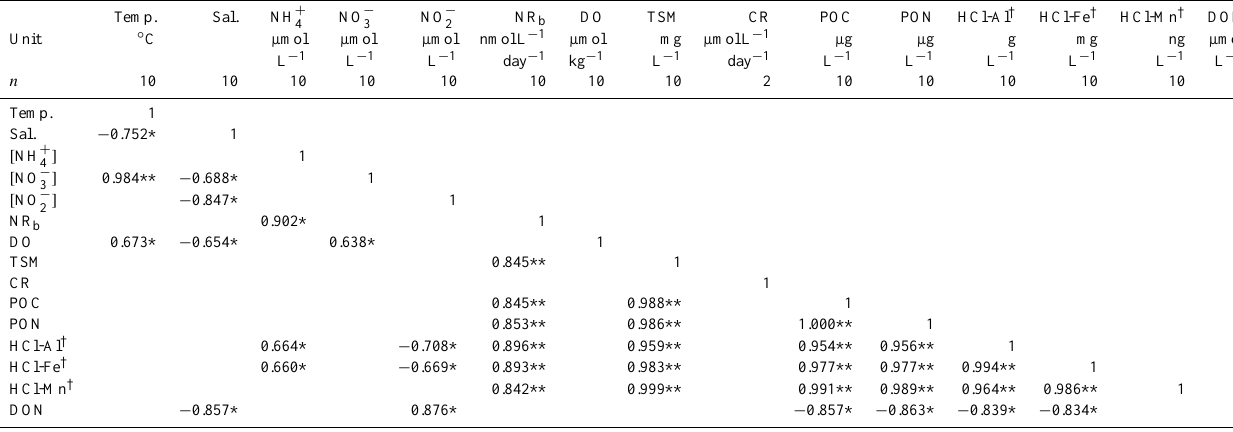
Table 2a. Correlation matrix of field-surveyed data in the river mouth of the Chang Jiang River plume. Temp. Sal.